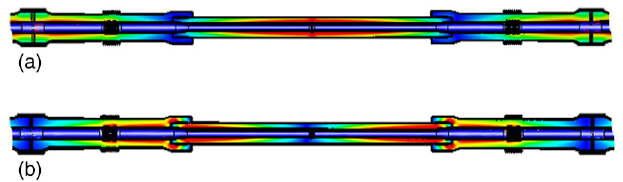
FIG. 8. The Smith Charts of the test system with the electric probe (a: under coupling, minimum S 11 ¼ − 2 . 5 dB) and the magnetic loop (b: over coupling, minimum S 11 ¼ − 8 . 1 dB). The left short is at z ¼ − 88 cm, and h ¼ 1 mm.